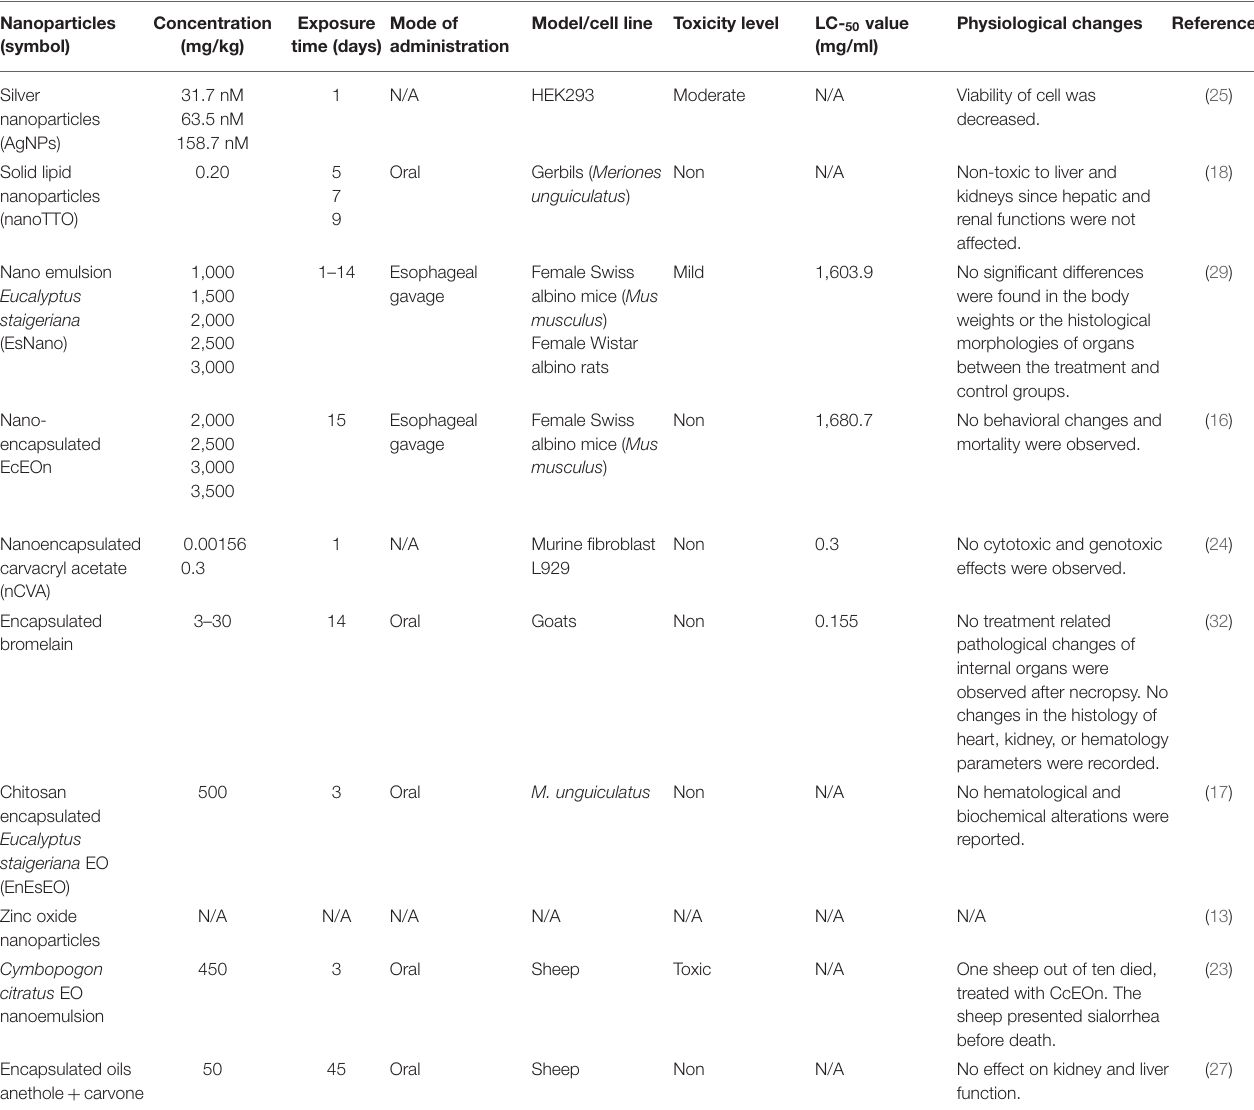
TABLE 5 | Toxicity of nanoparticles used against H. contortus . Nanoparticles